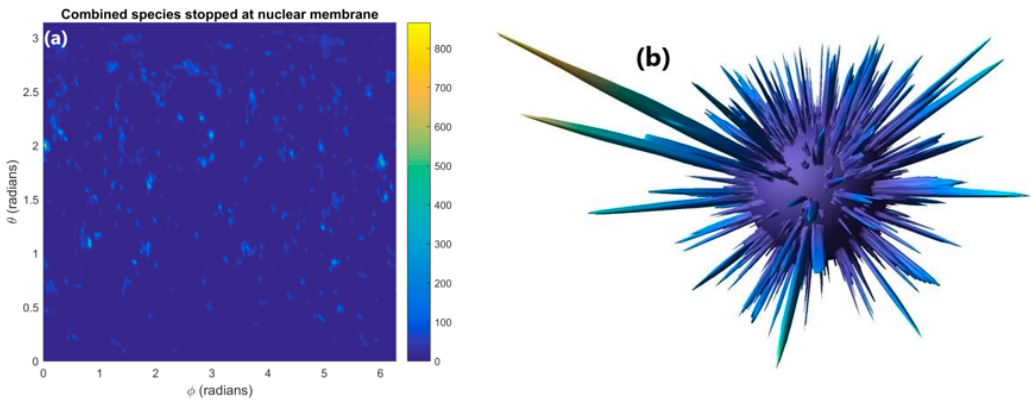
Figure 4. ( a ) The distribution of reactive species stopped within the nuclear membrane. ( b ) A 3D plot with the concentration of reactive species indicated by the distance from the surface of the sphere of the nuclear membrane.